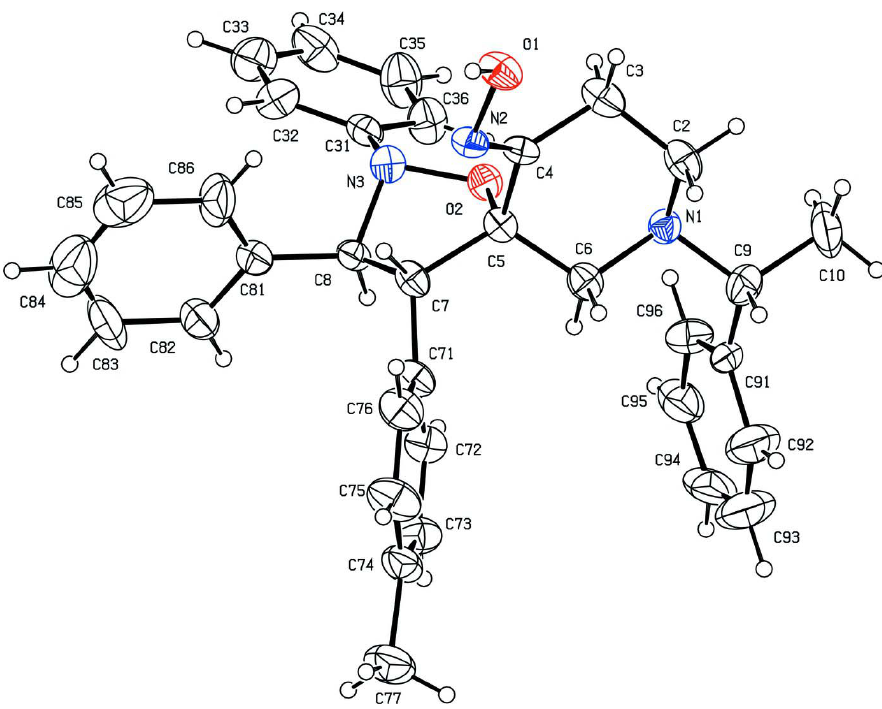
Figure 1 The molecular structure of the title compound, showing 30% probability displacement ellipsoids and the atom-numbering